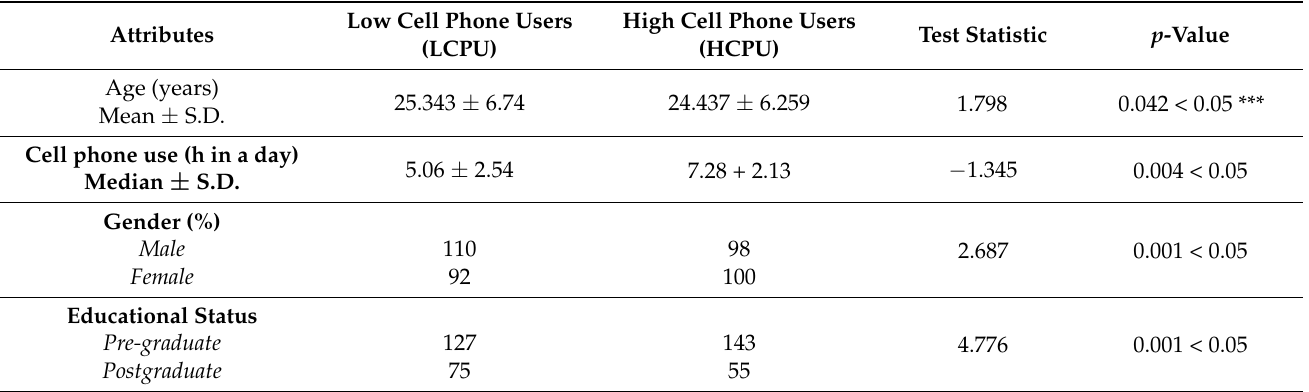
Table 1. Respondents’ general demographics and attributes with